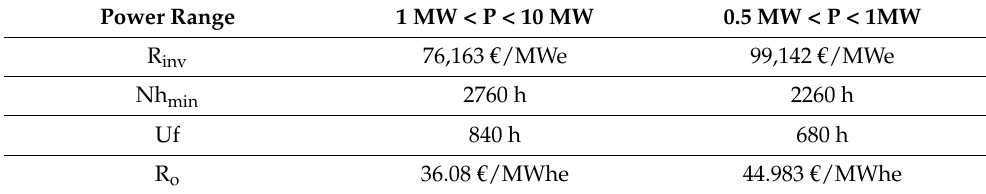
Table A7. Value of the parameters for economic balance calculation